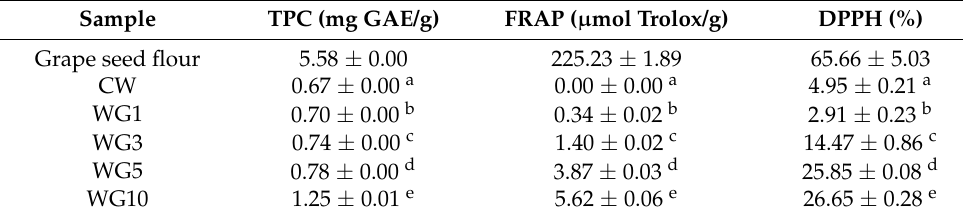
Table 2. Results Obtained for Control and Waffle Samples with Added Grape Flour: TPC, FRAP and DPPH. Sample TPC (mg GAE/g) FRAP ( µ mol Trolox/g) DPPH (%) Grape seed flour 5.58 ±